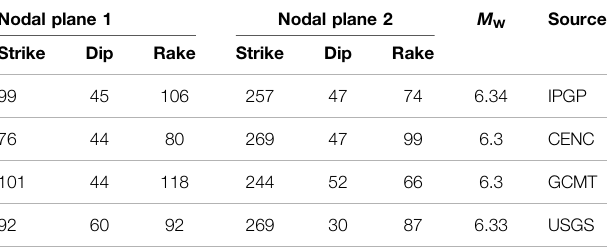
TABLE 2 | Focal mechanism solutions of the 2017 Jinghe earthquake. Nodal plane